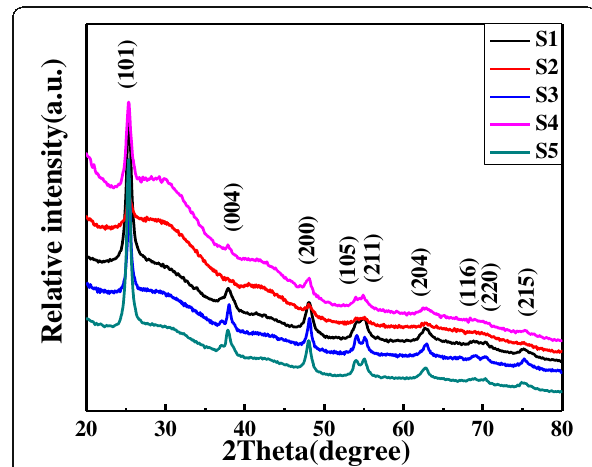
Fig. 2 XRD profiles of TNT arrays